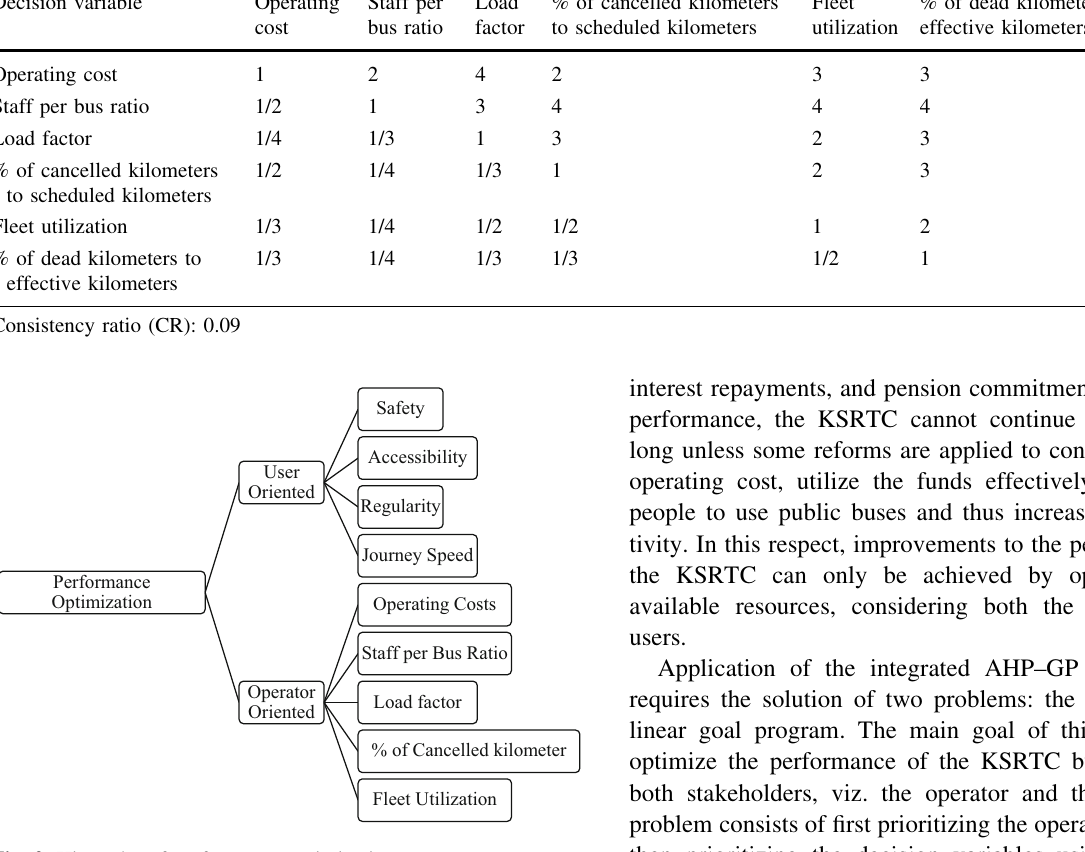
Fig. 2 Hierarchy of performance optimization process